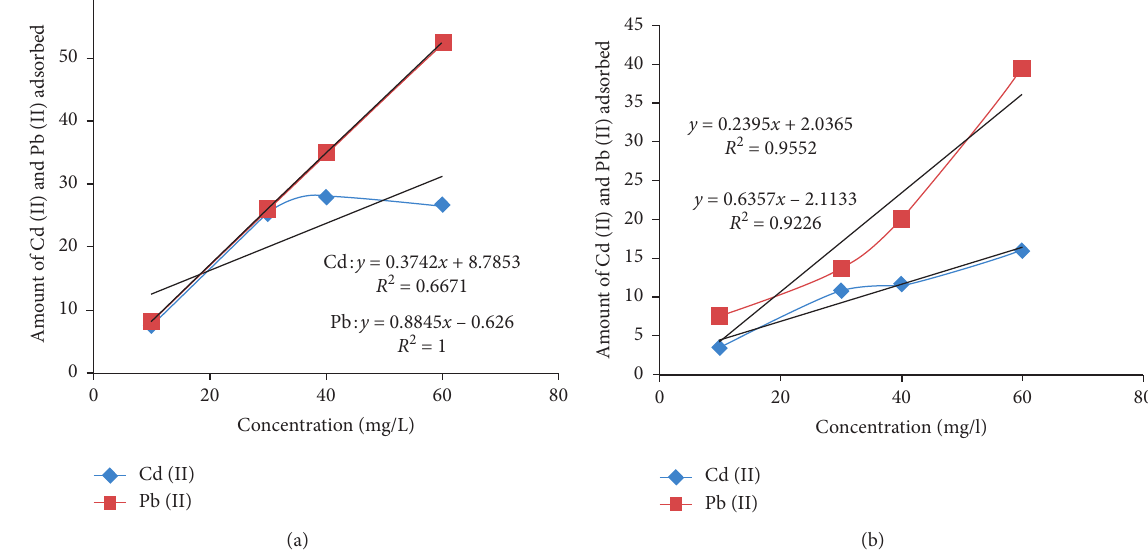
Figure 4: Graph of Cd (II) and Pb (II) adsorption on clay-1 (a) and clay-2 (b) at varying